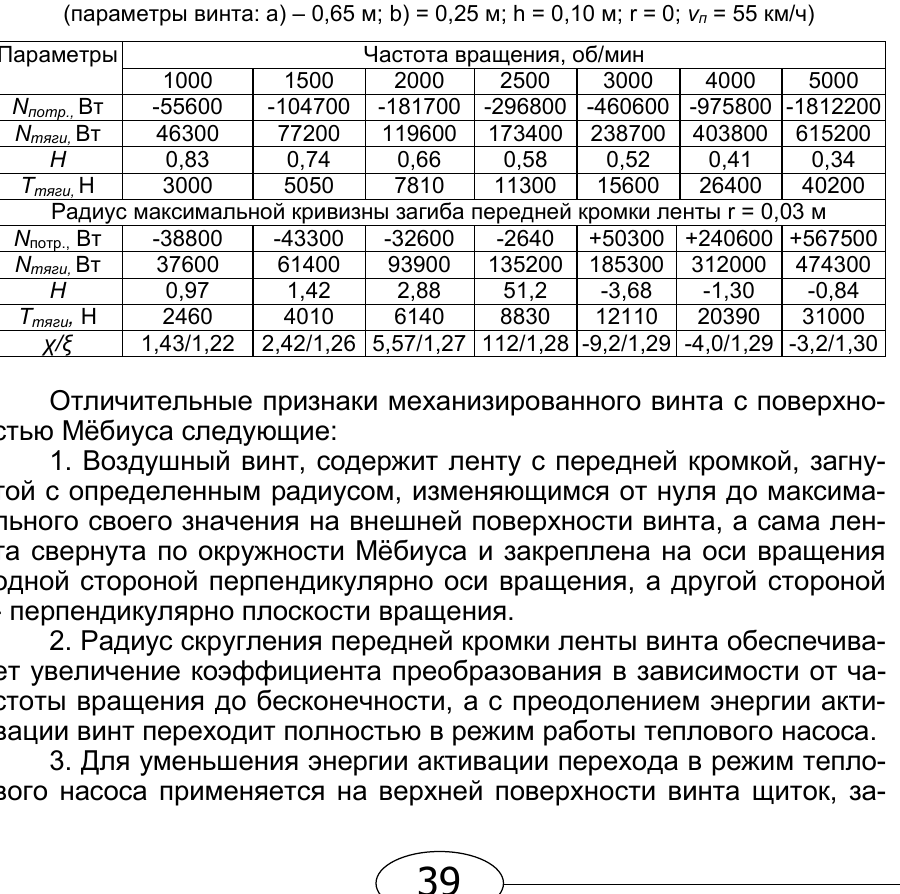
Table 1 – omparison of the Mobius propeller functioning with and without bending the strip outer